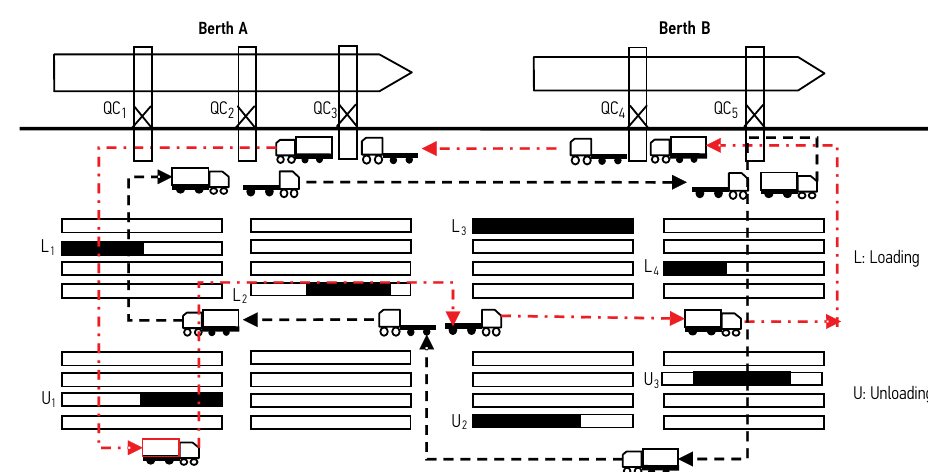
Fig. 2. Process of mix